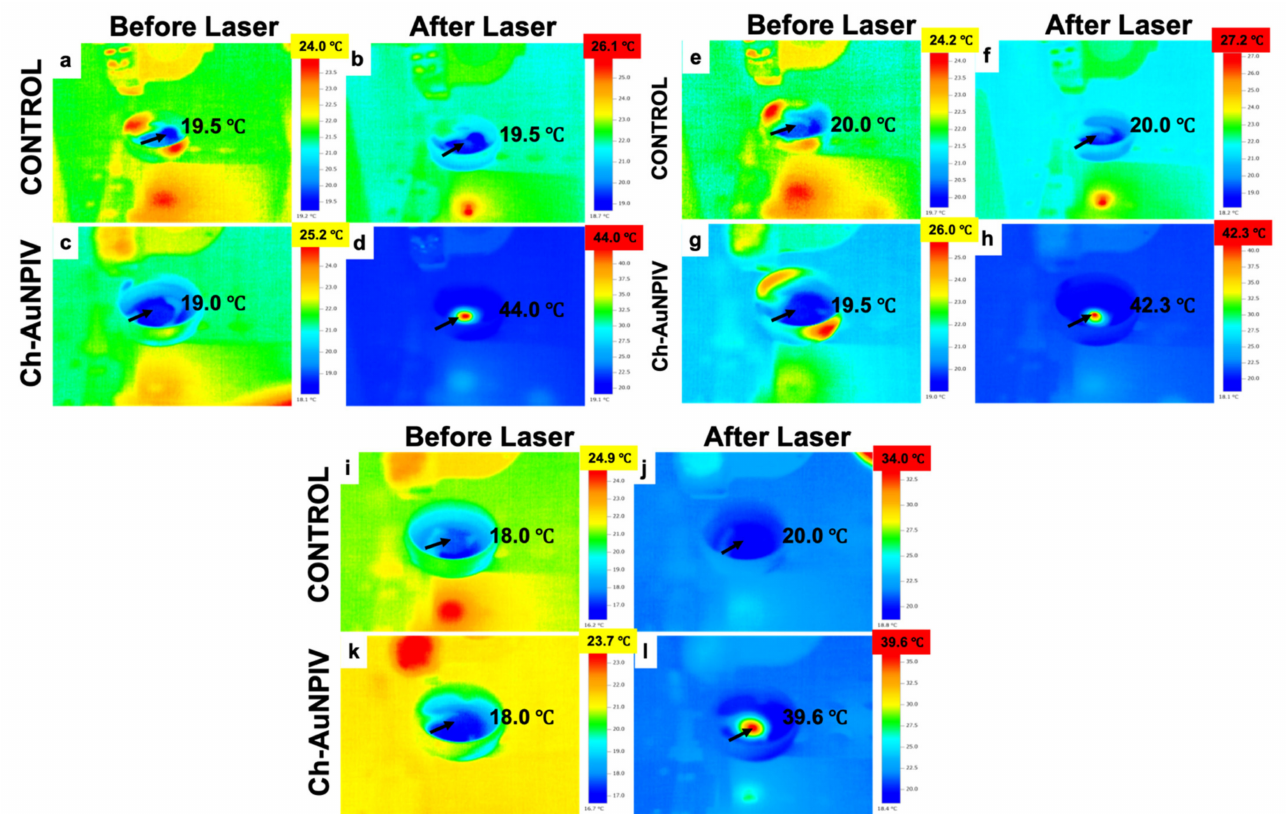
Figure 7. In vitro PTT of brain cancer cells. ( a – d ) A1207 cells, ( e – h ) LNZ308 cells, ( i – l ) U87 cells. It could be observed that the temperature of cells treated with Ch-AuNPs and further irradiated with an NIR laser, rose considerably enough to negatively affect the cell